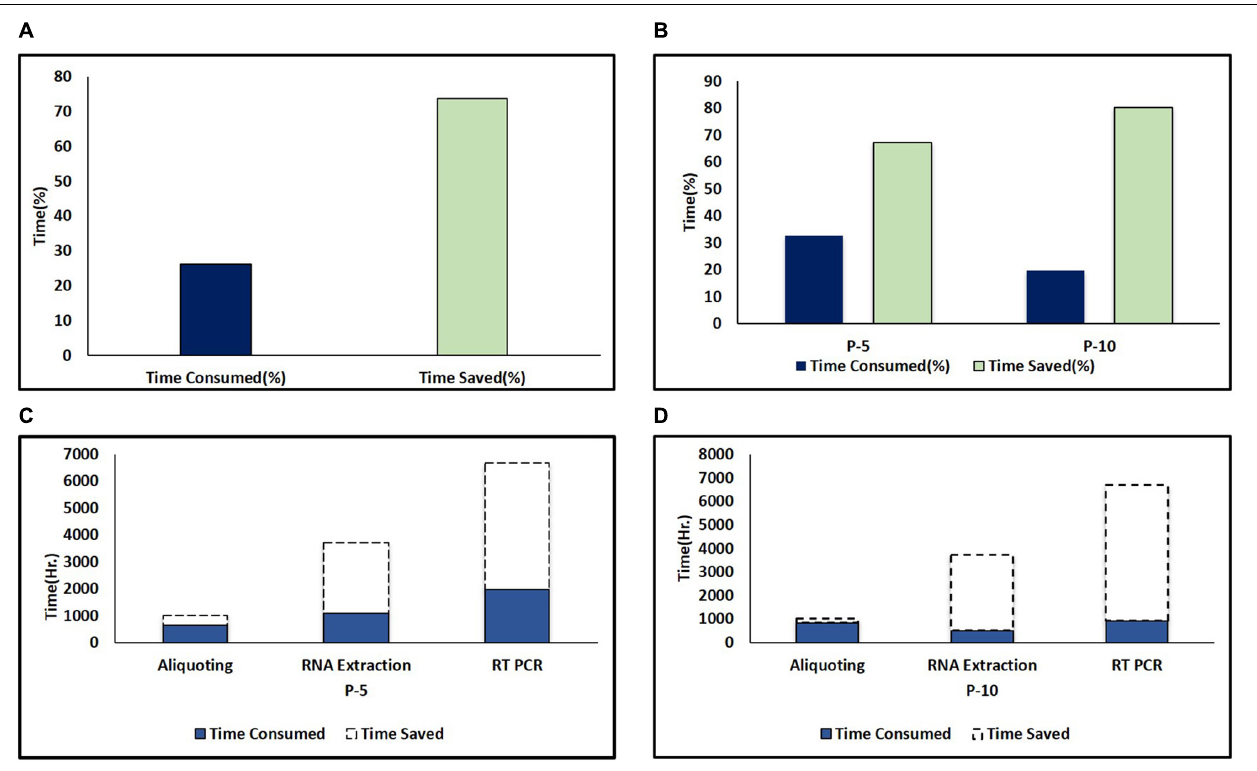
FIGURE 3 | Time saved in pooling strategies. (A) Percent time saved during pooling strategies (combined of P-5 and P-10). The dark color column represents time consumed and the light color column represents time saved. (B) Comparison of percent time saved in P-5 and P-10 testing strategies. (C) Time saved in hours during different areas of testing including aliquoting, RNA extraction, and PCR during the P-5 testing strategy. (D) Time saved in hours during different areas of testing including aliquoting, RNA extraction and PCR during P-10 testing strategy. The dark color column and area under the dash line indicate the consumed and saved time in different areas of the testing protocol due to pooling